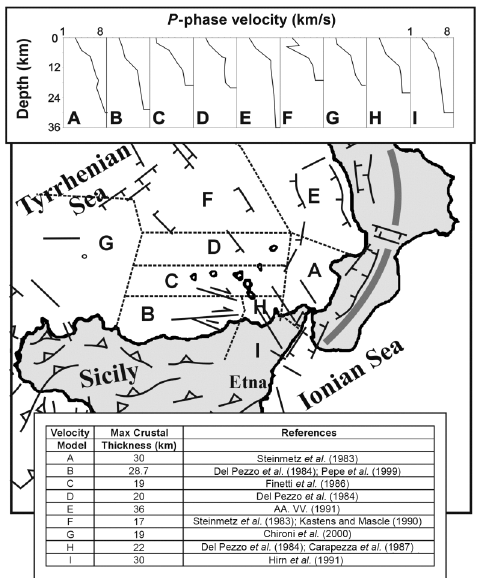
Fig. 3. Subdivision of the Southern Tyrrhenian Sea in 9 sub-zones (structural map of south Italy modified from Meletti et al. , 2000), each of them characterised by a different velocity model. On the upper part the pattern of P -phase velocity versus the depth for the dif- ferent models is shown. On the bottom, the table rep- resenting the maximum crustal thickness of each ve- locity model with the relative references is